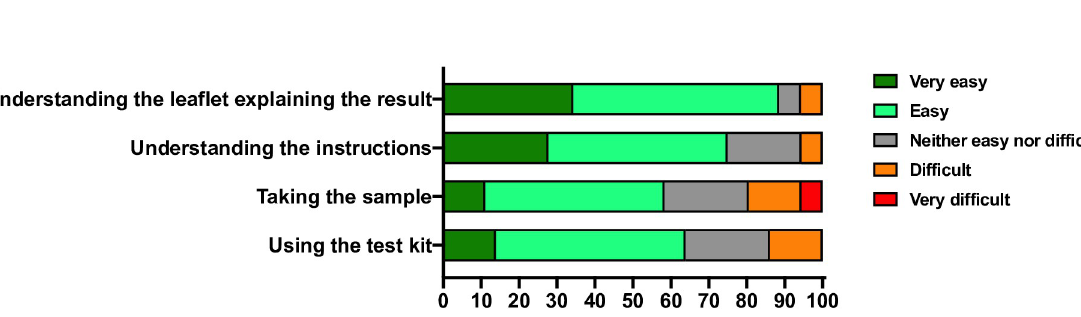
Fig 5. Sensitivity comparison between paired serum and capillary samples. Sensitivity for POC devices comparing serum, and HCW and participant interpreted capillary data. Sensitivity and 95% CI (Clopper-Pearson) were plotted.